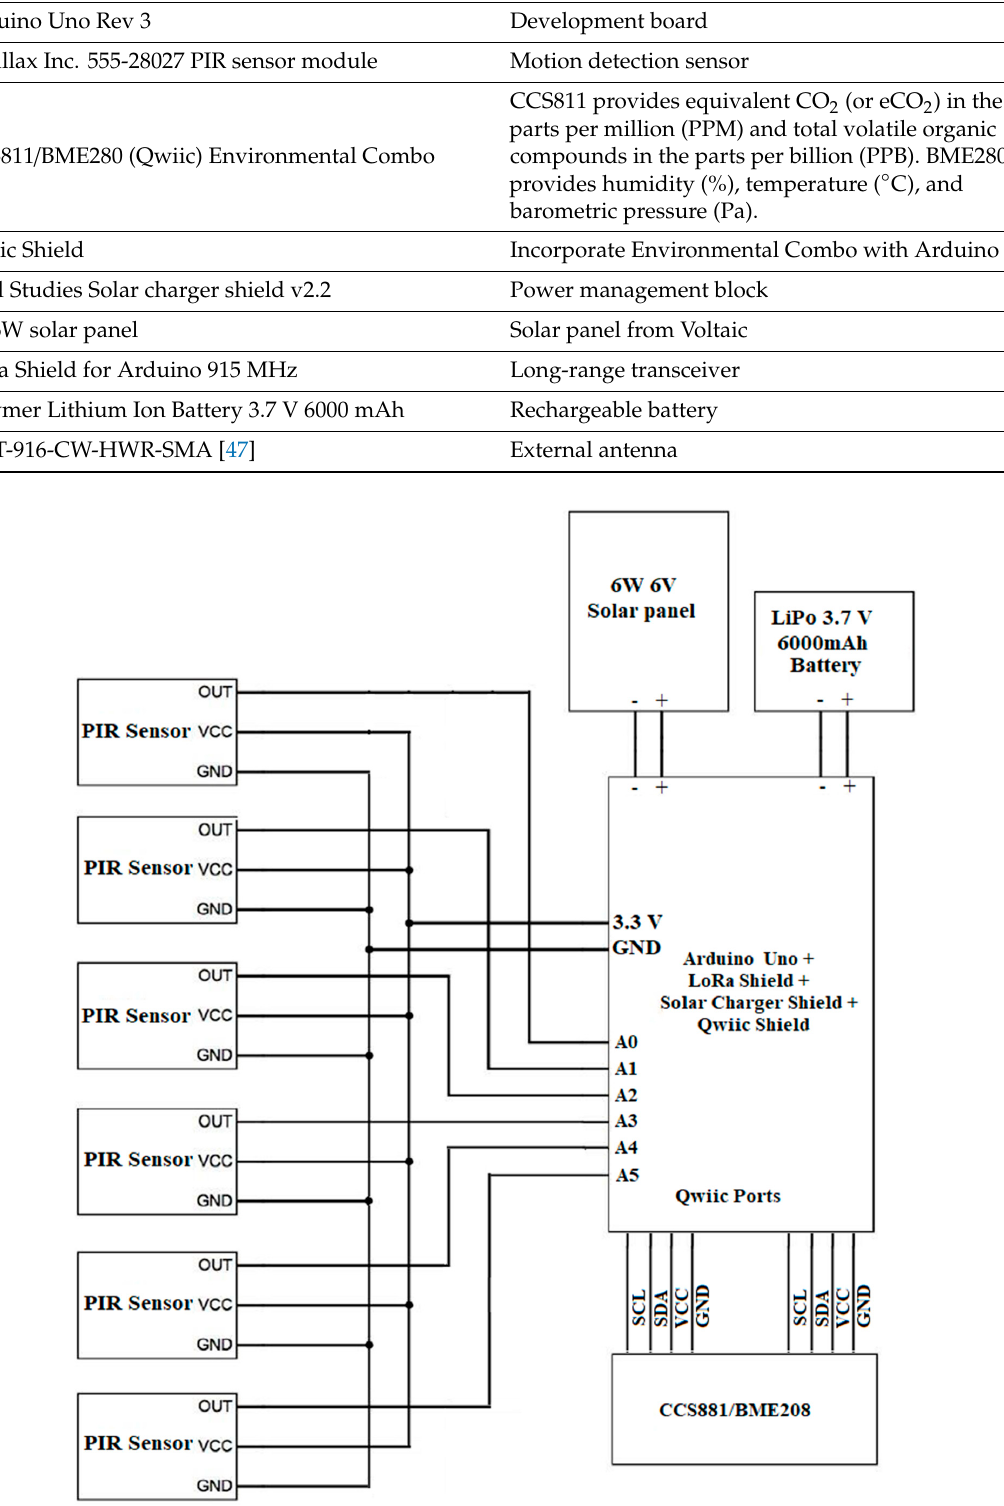
Figure 3. Circuit diagram of the proposed system.